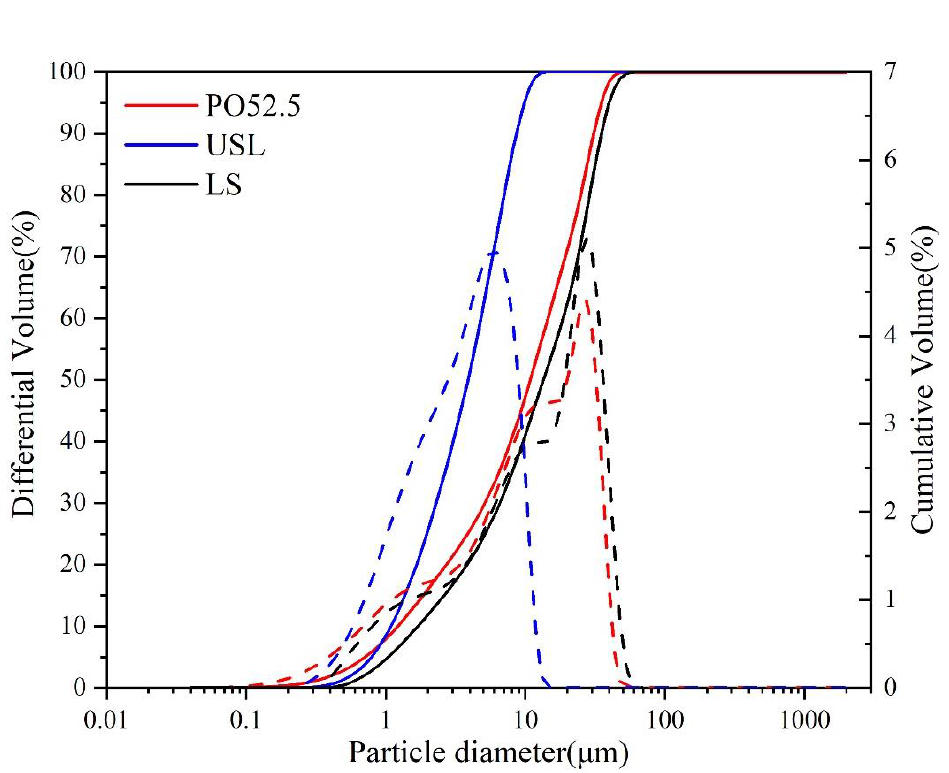
Figure 1. Particle distribution of P·O 52.5, USL, and LS.